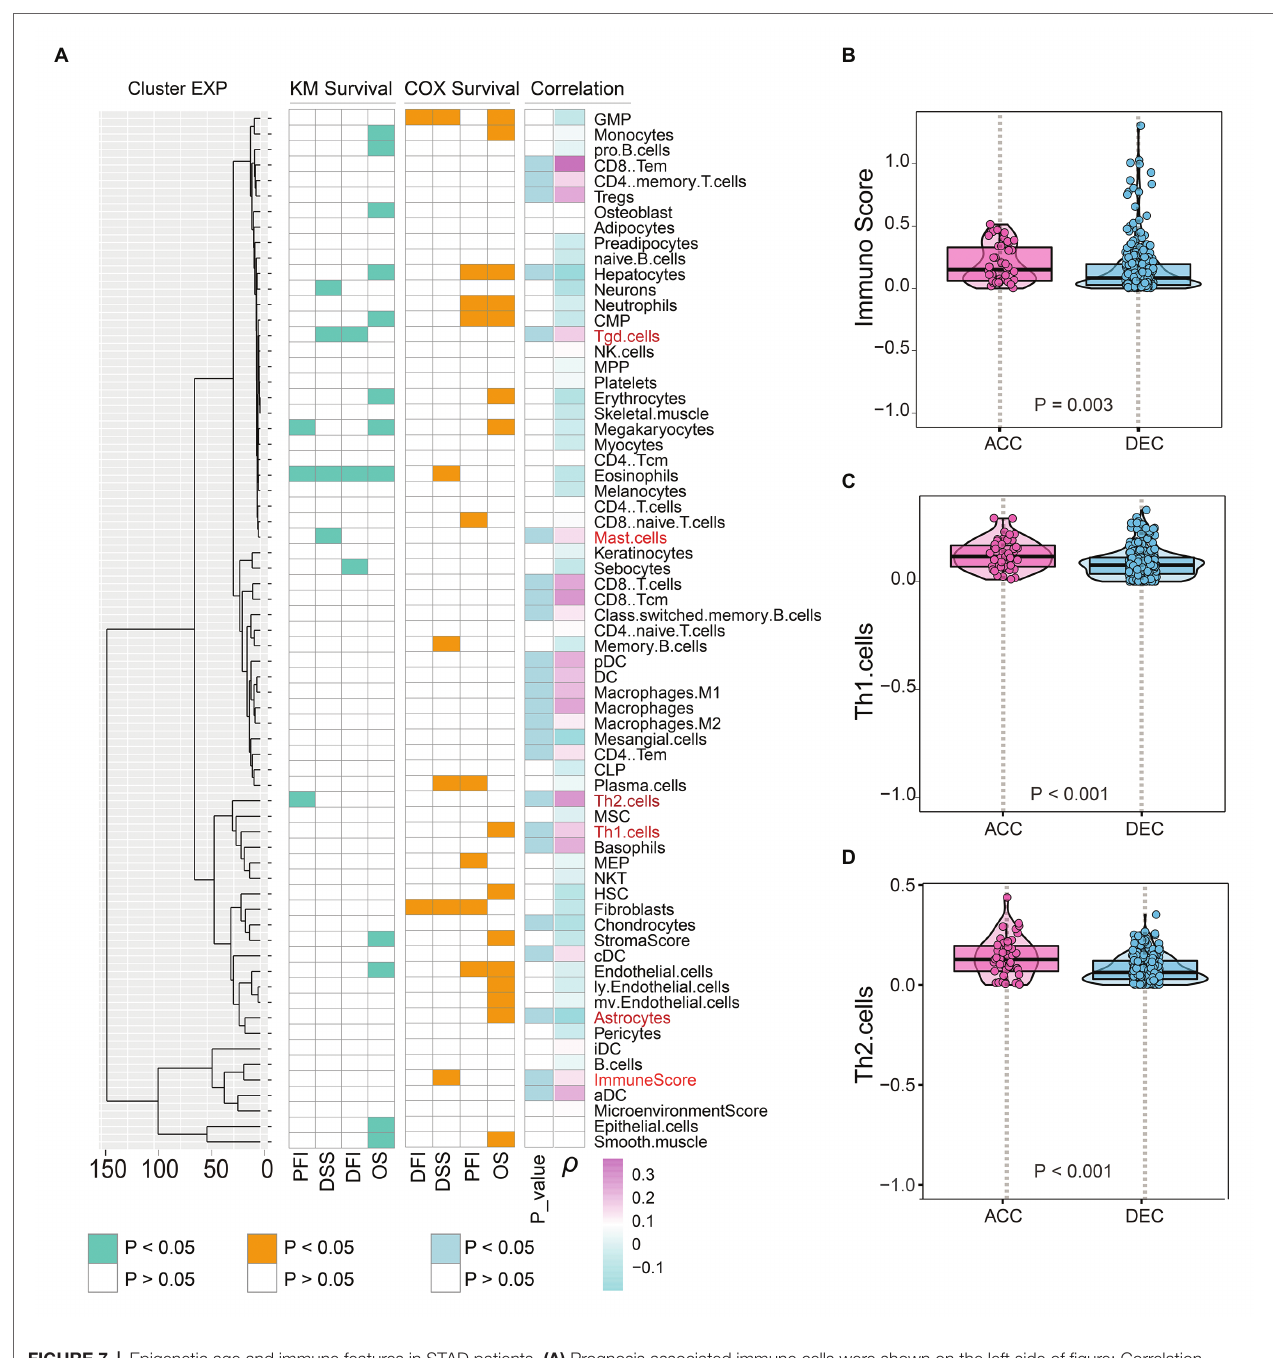
FIGURE 7 | Epigenetic age and immune features in STAD patients. (A) Prognosis associated immune cells were shown on the left side of figure; Correlation between DNAm age and immune cells was shown on the right side of figure. DNAm age accelerated group showed higher immune score (B) , Th1 cells (C) , and Th2 cells (D) than DNAm age decelerated group. OS, overall survival; DSS, disease specific survival; PFI, progression free interval event; DFI, disease free interval event; S, results of Kaplan-Meier survival analysis; COX, results of univariate Cox regression analysis; ACC, DNAm age accelerated group; DEC, DNAm age decelerated group; ρ , correlation coefficient; STAD, stomach